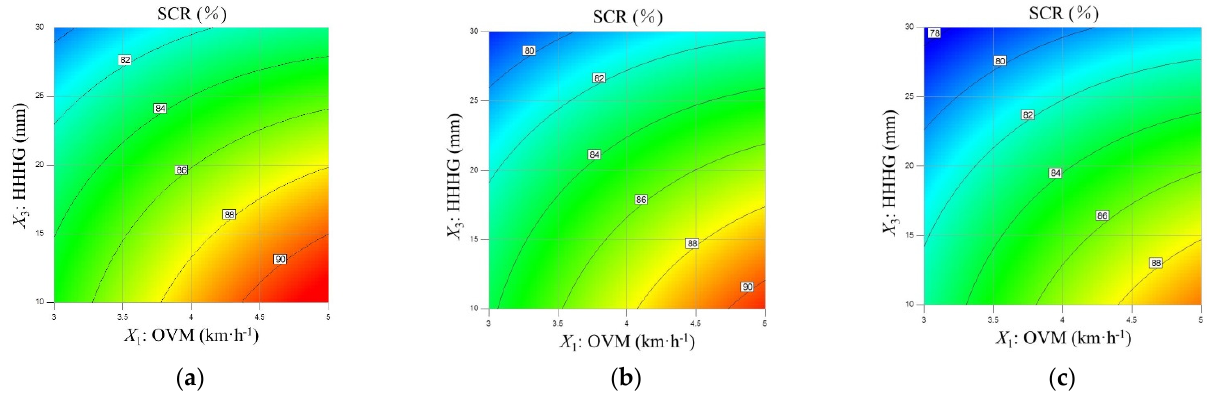
Figure 9. Effects of interaction factors on the SCR. ( a ) X 2 = 80 r/min; ( b ) X 2 = 120 r/min; ( c ) X 2 = 160 r/min. ( c ) X 2 = 160